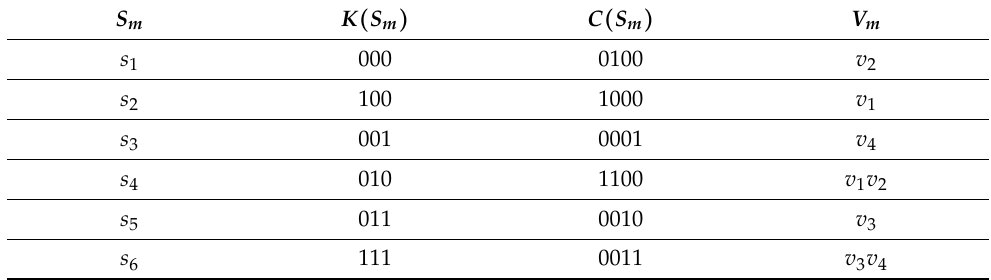
Table 6. Table of block LV.